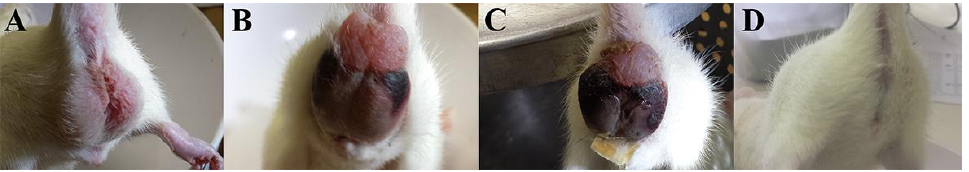
There were no complications during the MNH procedure in any of the treated ani-